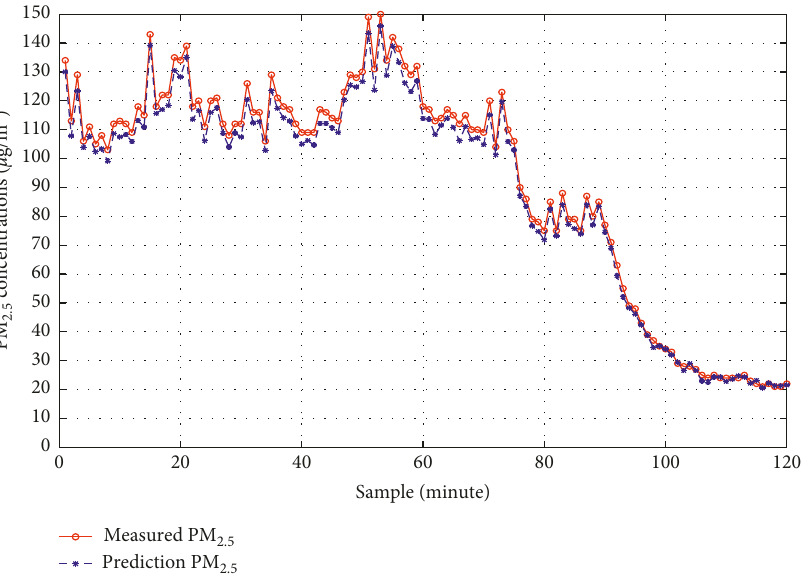
Figure 8: PM 2.5 concentration prediction result of model 4